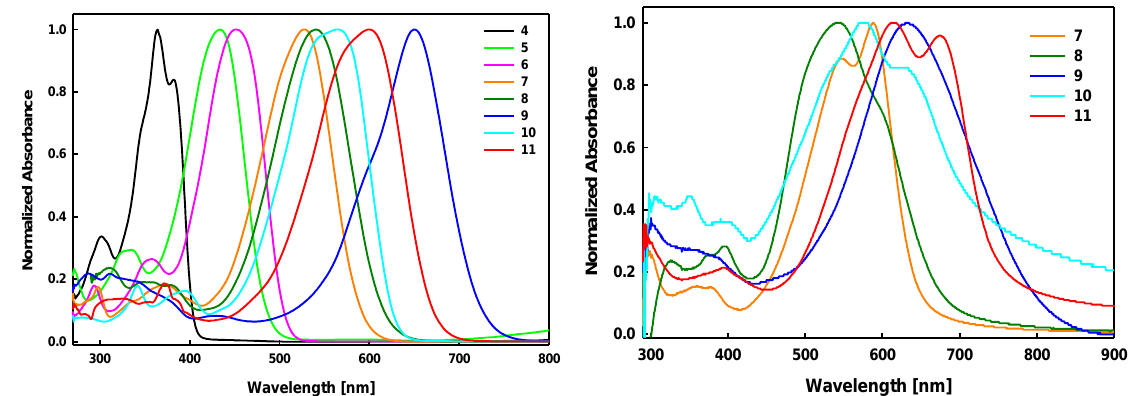
Figure 1. Normalized UV-vis absorption spectra of derivatives 4 – 11 in solution (chloroform for 5 – 7 , 9 – 11 and dichloromethane for 4 and 8 ) (left) and in thin films (right). Moreover, as outlined in Table 1, the molar absorption coefficient (ε) of the low energy absorption bands of the A-D-A systems (79.8 – 98 × 10 3 M −1 cm −1 ) is higher than that of the unsymmetrical counterparts (62.5–61.7 × 10 3 M − 1 cm − 1 ), suggesting a better ability of light